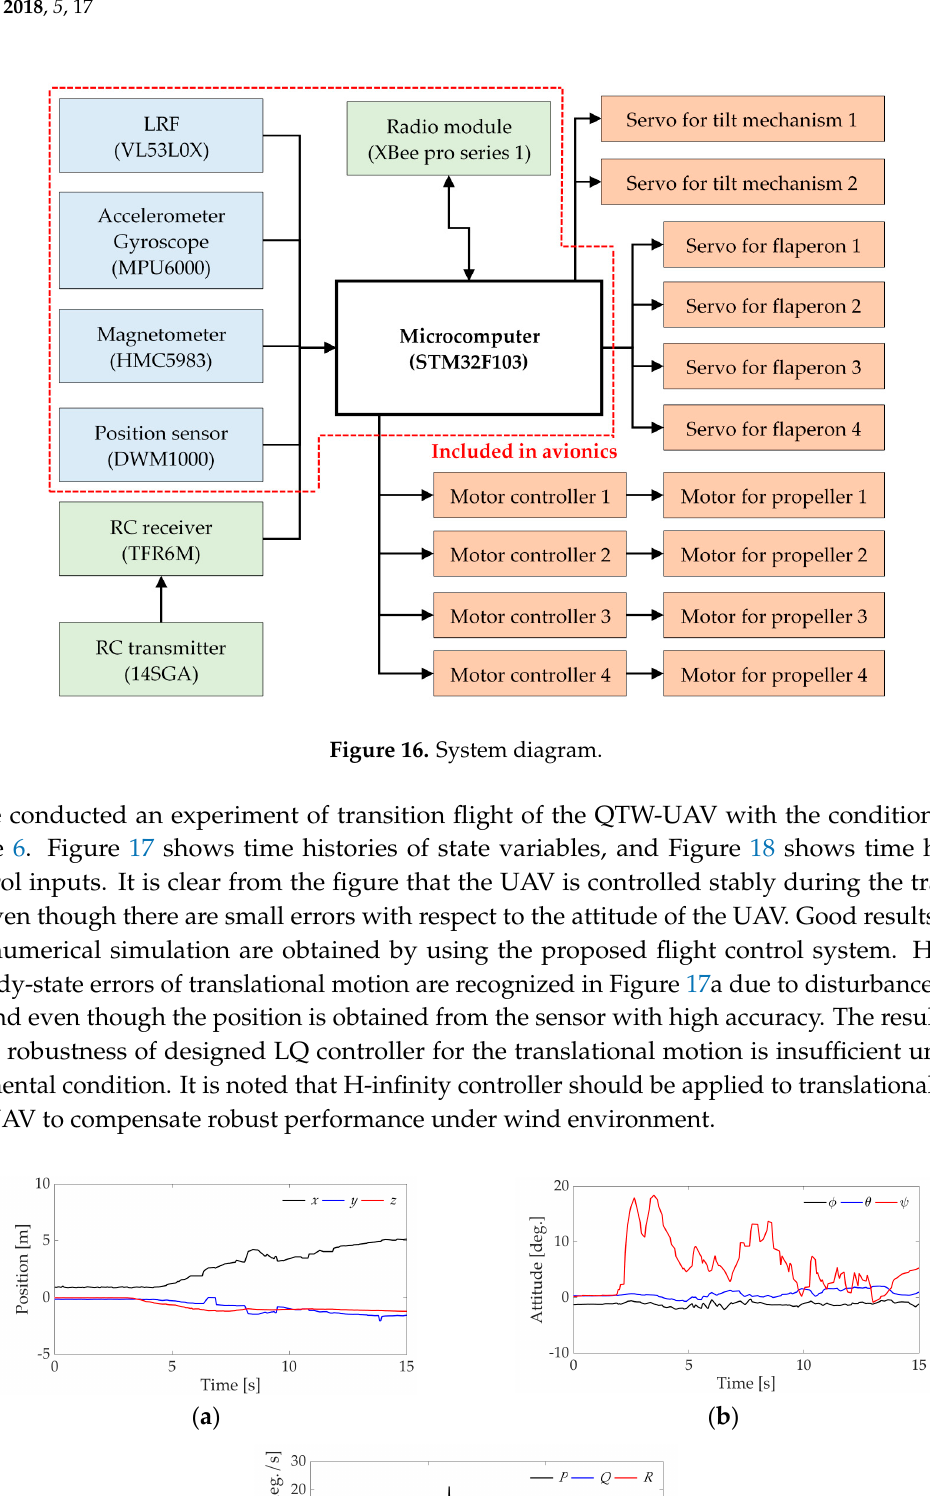
Figure 15. Developed ( a ) QTW-UAV and ( b ) avionics.